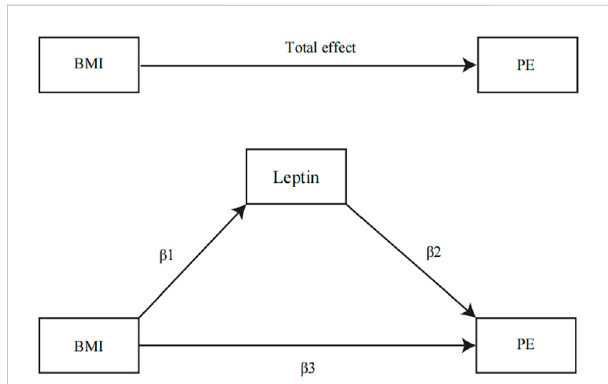
FIGURE 1 Illustration of parameters estimated to obtain total, direct, and indirect effects: β 1, the MR effects of BMI on the potential mediator; β 2, the MR effect of the circulating leptin levels with PE adjusted for genetically determined BMI; β 3, the MR effect of BMI on PE adjusted for the genetically determined circulating leptin levels. The total effect was determined by β 1* β 2 + β